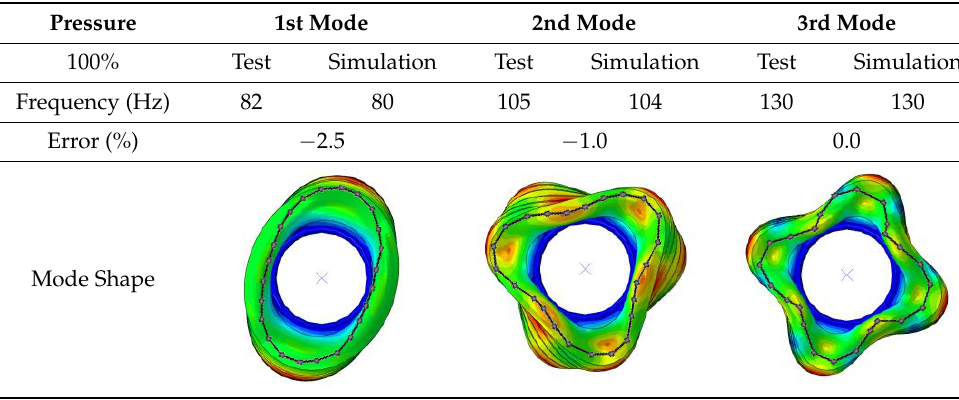
Table 7. Comparison of the modal frequencies and modal shape between the experiment and simulation (Pressure 100%).